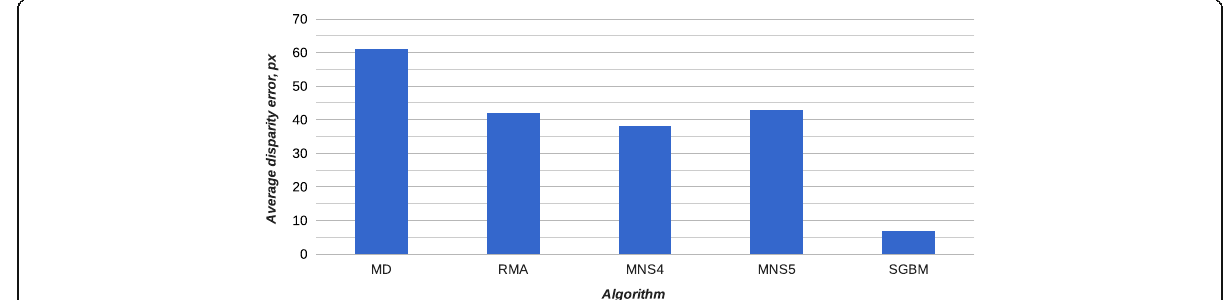
Fig. 12 The average disparity error of bad pixels. Evaluation performed on H resolution training set images